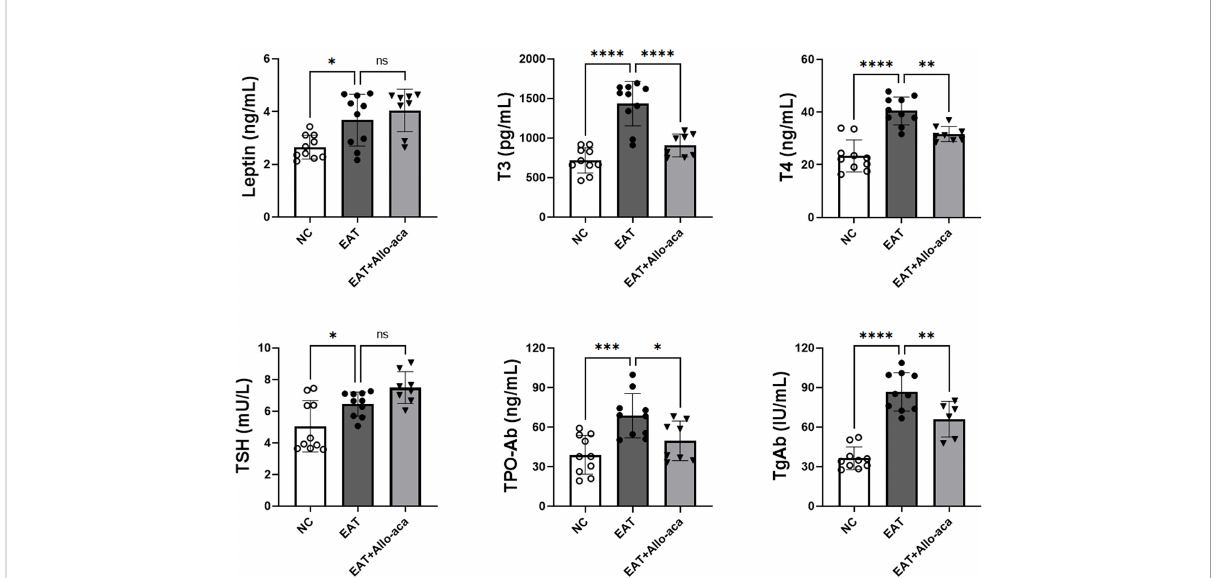
FIGURE 4 Serum leptin, thyroid hormone, and thyroid autoimmune antibody levels in experimental mice. Serum leptin, T3, T4, TSH, TPO-Ab, and TgAb expressions were all up-regulated in high iodine-induced EAT mice. Allo-aca reduced serum T3, T4, TPO-Ab, and TgAb levels in EAT mice. n =10, data are expressed as mean ± standard deviation, ns : not signi fi cant, * P < 0.05, ** P < 0.01, *** P < 0.001, **** P < 0.0001.